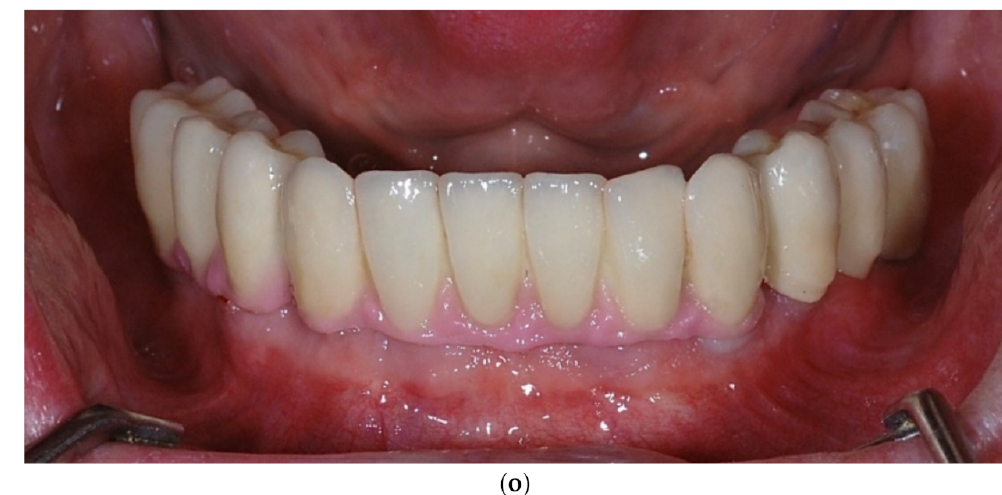
Figure 1. ( a ) A.C., aged 65. Preoperatory intraoral view. ( b ) Preoperative CBCT images and alveolar bone parameters measured with Sidexis XG/ DVT (Densply/Sirona) software. ( c ) Intraoral view after the insertion of osteosynthesis screws and implants. ( d ) Intraoral view after the mandibular alveolar reconstruction with S-GBR technique and porcine xenograft. ( e ) Postoperative intraoral view after wound suture and temporary loading. ( f ) Alveolar bone width values measured at baseline ( left ) and at 6 months follow-up with Sidexis XG/ DVT software (Densply/Sirona). ( g ) Alveolar bone width values measured at baseline ( left ) and at 6 months follow-up with Sidexis XG/ DVT software (Densply/Sirona). ( h ) Alveolar bone width values measured at baseline ( left ) and at 6 months follow-up with Sidexis XG/ DVT software (Densply/Sirona). ( i ) Alveolar bone width values measured at baseline ( left ) and at 6 months follow-up with Sidexis XG/DVT software (Densply/Sirona). ( j ) Alveolar bone osteodensity values measured at baseline ( left ) and at 6 months follow-up ( right ) (implant site 4.1). ( k ) Alveolar bone osteodensity values measured at baseline ( left ) and at 6 months follow-up ( right ) (implant site 4.5). ( l ) Alveolar bone osteodensity values measured at baseline ( left ) and at 6 months follow-up ( right ) (implant site 3.2). ( m ) Alveolar bone osteodensity values measured at baseline ( left ) and at 6 months follow-up ( right ) (implant site 3.5). ( n ) Preloading intraoral view. ( o ) Postloading intraoral